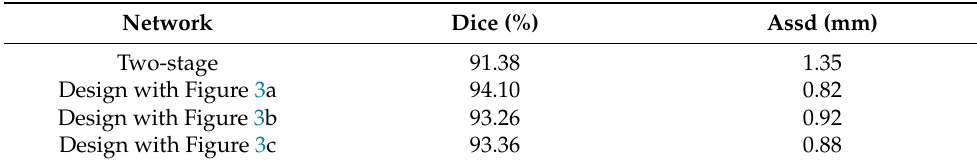
Table 2. Performance comparison of distance map methods.